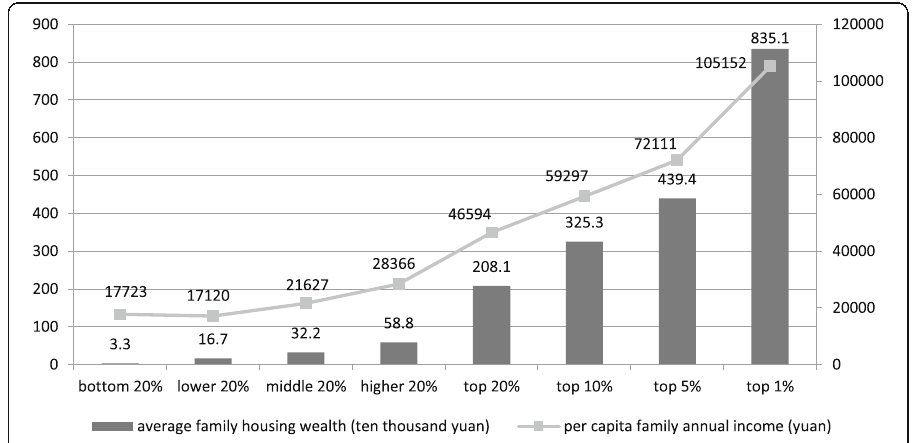
Fig. 2 Average family housing wealth and per capita family annual income of the housing wealth